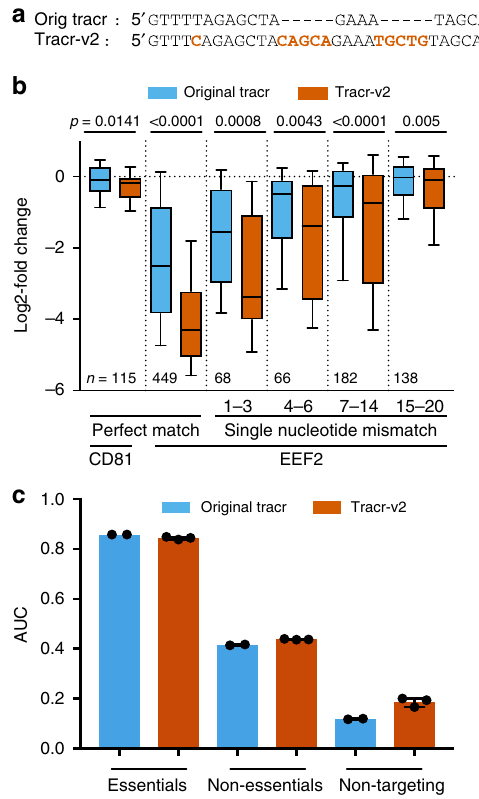
Fig. 2 Evaluation of an alternative tracrRNA. a Comparison of the sequence of the original tracrRNA and tracr-v2. b Comparison of the log2-fold-change of perfectly matched sgRNAs and single base mismatches targeting the essential gene EEF2 for the original tracrRNA and tracr-v2. CD81 -targeting sgRNAs serve as the control. Mismatched sgRNAs are binned by position, and are numbered such that nt 20 is PAM-proximal. The box represents the 25th, 50th, and 75th percentiles, and whiskers show 10th and 90th percentiles. Two-tailed Welch ’ s t -test was used to compare the distributions within each bin and p -values are indicated.The number of sgRNAs in each comparison is shown at the bottom. c AUC values for essential, non-essential, and non-targeting gene sets with the original tracrRNA and tracr-v2 in genome-wide viability screens. Error bars represent the range of two or three biological replicates for screens with the original and modi fi ed tracrRNA,